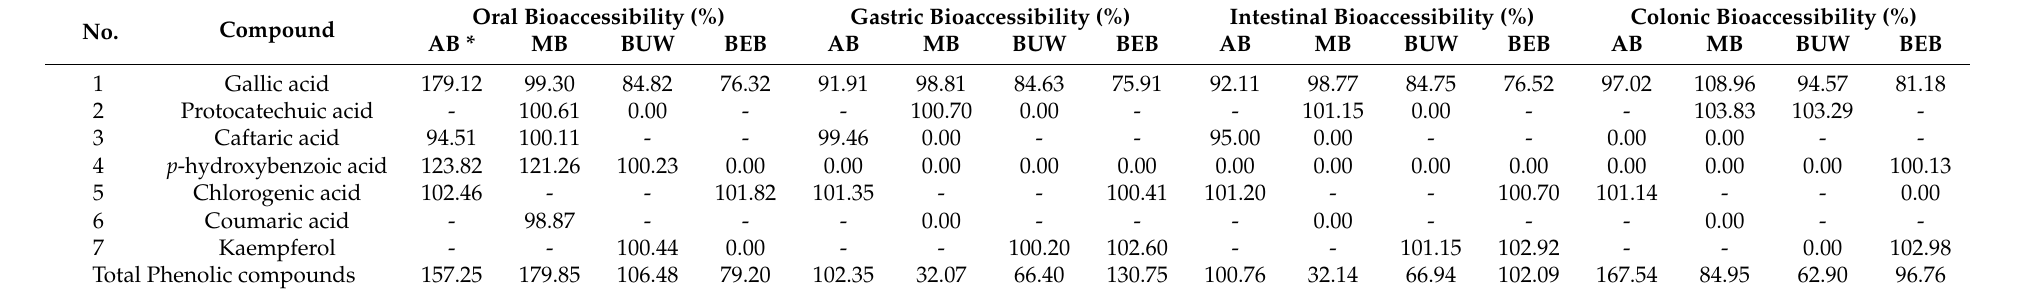
Table 1. Estimation of bioaccessibility (%) after complete in vitro digestion and colonic fermentation for phenolic compounds of legumes.